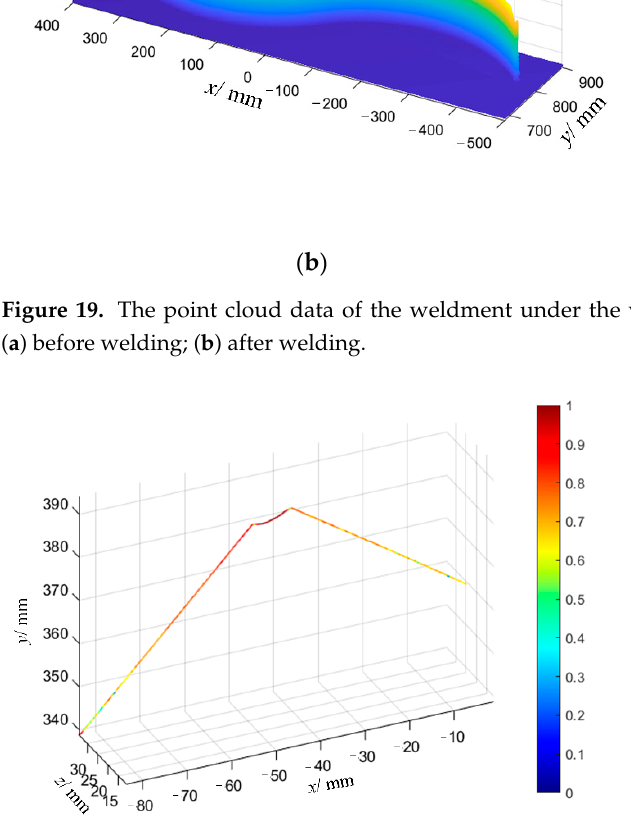
Figure 20. Contour comparison curves under welding sequence “ ②④③⑤①⑥ ”.